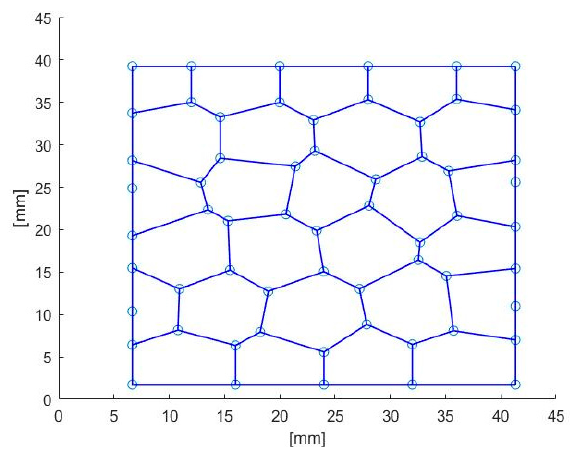
Figure 3. The Voronoi tessellation generated in MATLAB.